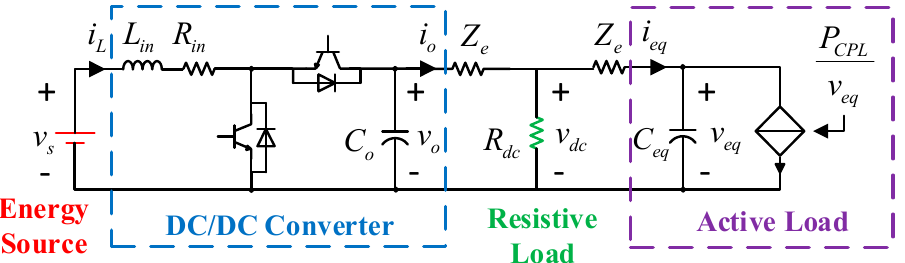
Figure 1. Equivalent circuit diagram of the studied dc microgrid system.